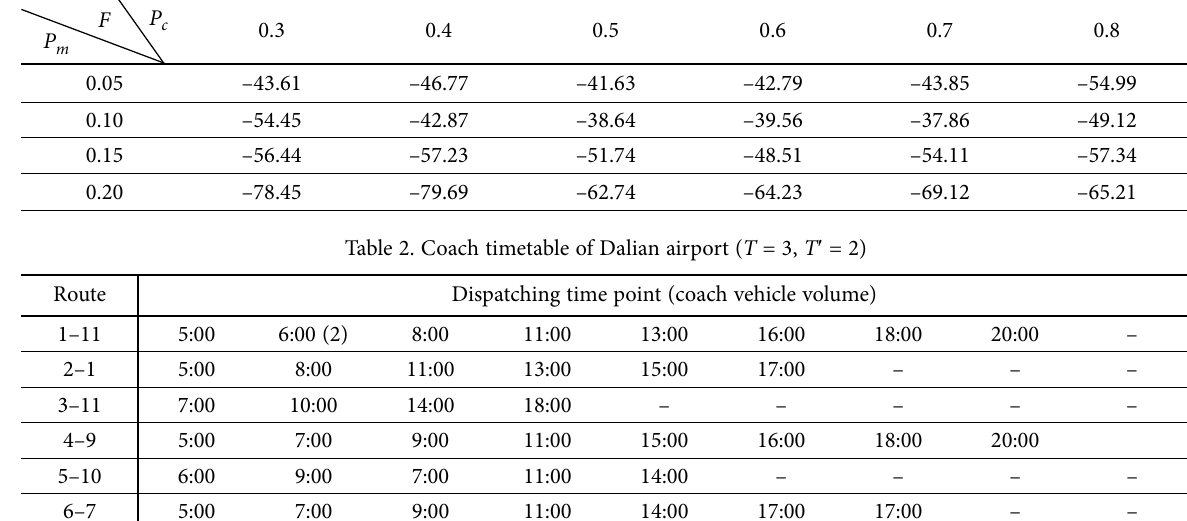
Table 1. Fitness value corresponding to different combination of P c and P m